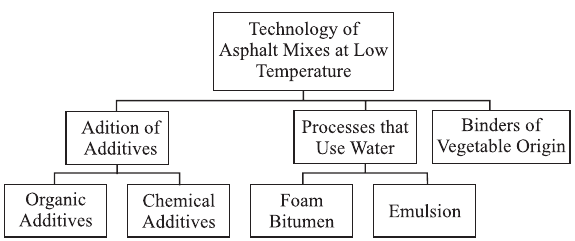
Fig. 1. Diagram of technologies in asphalt mixes at low